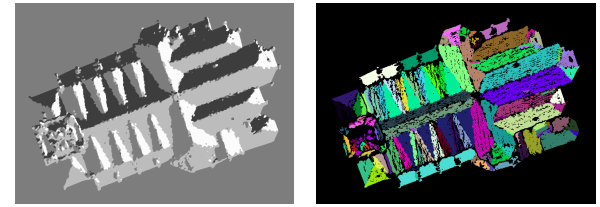
Figure 7: From left to right: Segmentation result after thresh- olding and points of detected roof facets that fit with the facets estimated plane. Each facet is marked with a different color.